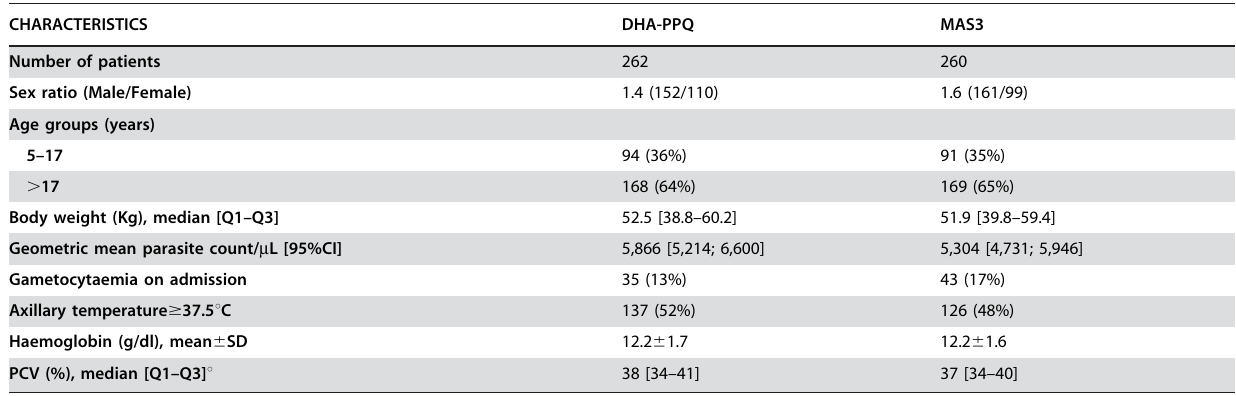
Table 1. Baseline characteristics of all randomized patients by treatment group. .. ... .... ... ... .... ... ... .... ... ... .... ... ... .... ... ... .... ... ... .... ... ... .... ... ... .... ... ... .... ... ... .... ... ... .... ... ... .... ... ... .... ... ...